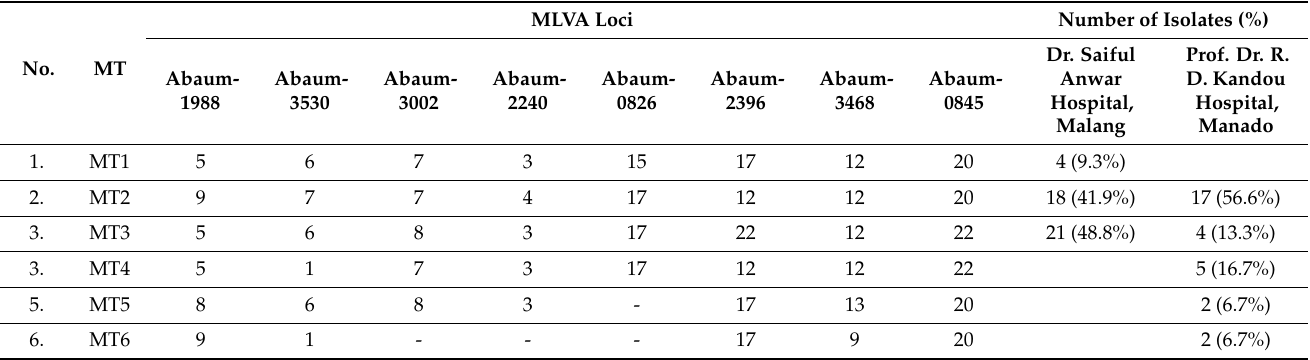
Table 4. MLVA typing results of CRAb-cc isolates obtained from Dr. Saiful Anwar Hospital, Malang,